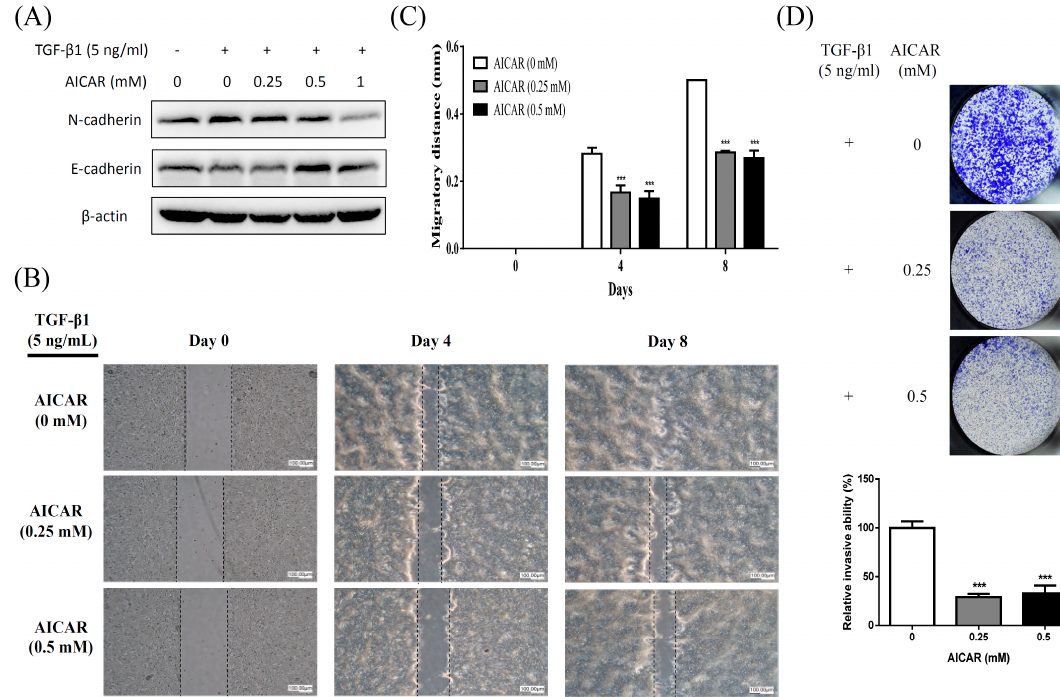
Figure 4. Effect of AICAR on transforming growth factor- β (TGF)- β -induced epithelial to mesenchymal transition (EMT), migration, and invasion in 22Rv1 prostate cancer cells. ( A ) Cells were treated with 5 ng/mL TGF- β 1 and different concentrations of AICAR for 72 h. The expression of N-cadherin and E-cadherin was analyzed by western blot. Actin was used as a loading control in western blot. The western blotting results are representative of results obtained in three separate experiments. ( B ) Cells were seeded in SPLScarTM Block overnight, the block was then removed, and cells were treated with 5 ng/mL TGF- β 1 and different concentrations of AICAR. Cell migration was monitored under a phase-contrast microscope. Data are representative of at least three independent experiments with similar results. ( C ) The migratory distance was calculated. ( D ) Cells were treated with 5 ng/mL TGF- β 1 and different concentrations of AICAR, then seeded into Matrigel transwell inserts for 5 days. The invaded cells were quantified using crystal violet staining. Data are represented as means ± SD of triplicate values and statistical significance was determined using the Student’s t -test (* p < 0.05; ** p < 0. 01; *** p < 0.001).